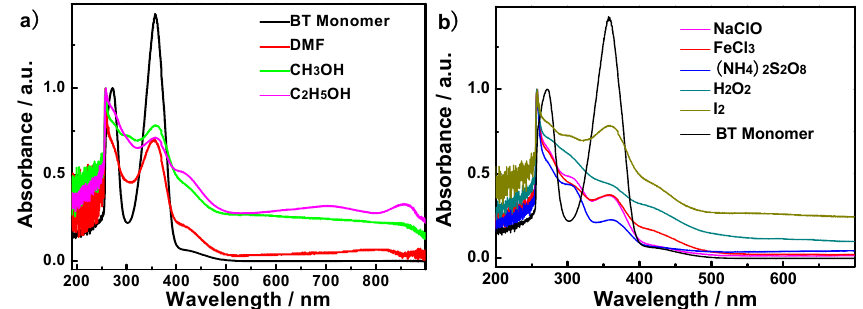
Figure 1. The UV-Vis spectra of 2,5-dimercapto-1,3,4-thiadiazole (BT) monomer and poly(2,5-dimercapto-1,3,4-thiadiazole) (PBT) polymers synthesized ( a ) in different media with an I 2 /BT molar ratio of 1.5, and ( b ) with the oxidant/BT molar ratio of 1.5 in ethanol, together with an initial BT concentration of 50 mmol L − 1 at 25 °C for 24 h.